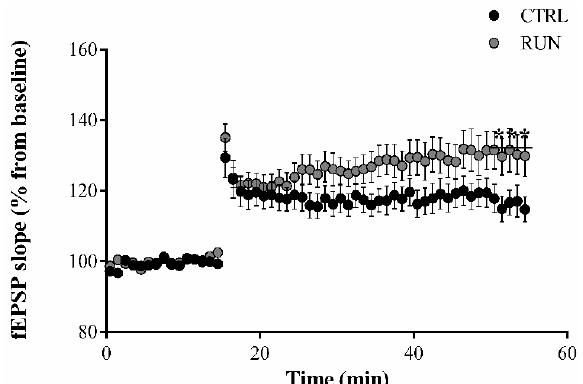
Figure 2. Electrophysiology analysis of long-term potentiation (LTP). The slope of EPSPs resulting from the parasagittal sections (400 µm) of the hippocampal region was analyzed. The slopes of the EPSP in the RUN group were significantly increased compared to CTRL group after recording for 40 min following high-frequency stimulation; in addition, the y-intercept in the last 10 min of recording was significantly higher in RUN group. Data statistical analysis: linear regression slope F = 7.09361, p < 0.01; y-intercept F = 32.0045, p < 0.0001.